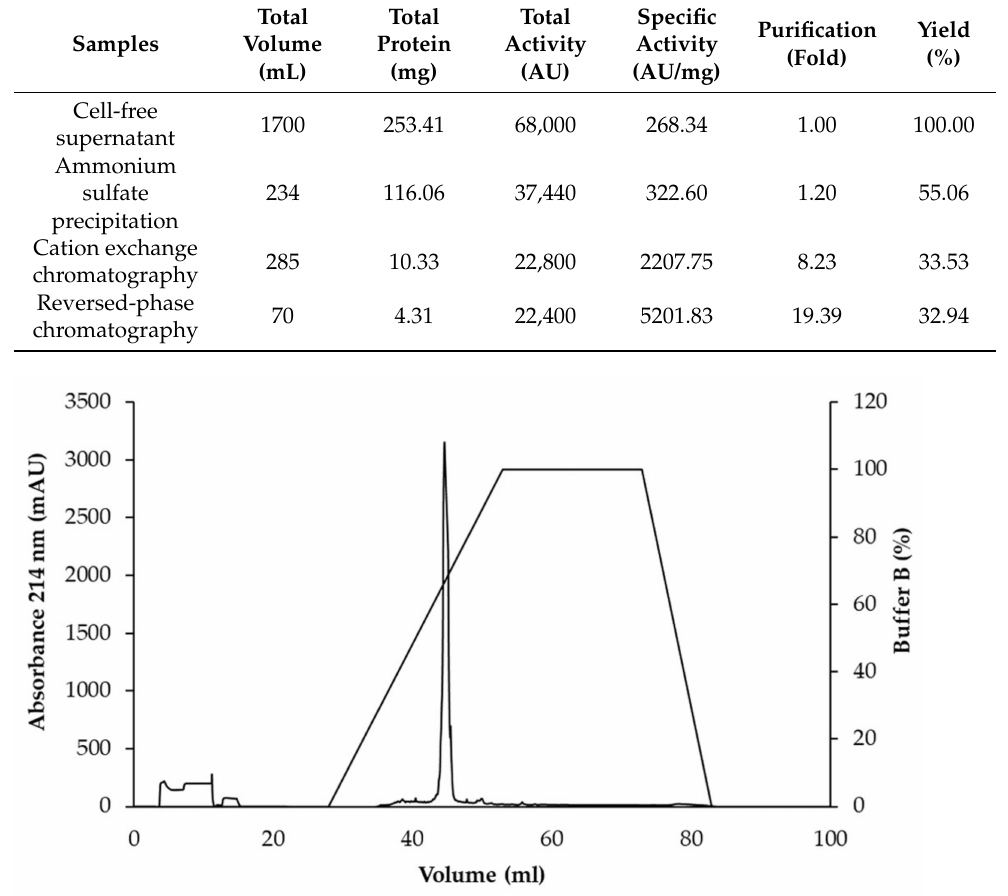
Figure 4. HPLC-chromatogram of an antimicrobial substance from WUL10.